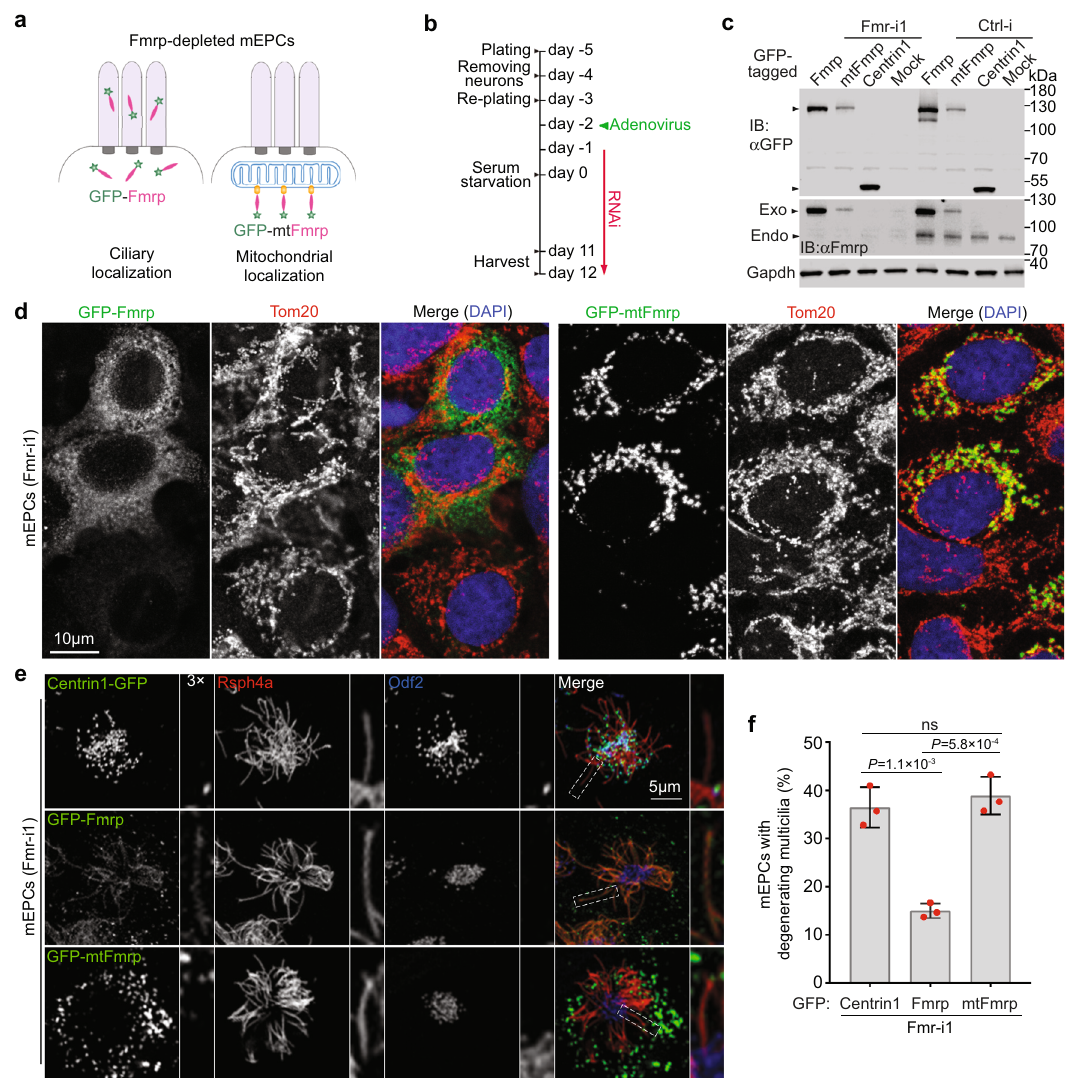
Fig. 6 Fmrp depletion-induced multicilia degeneration is attributed to the ciliary fraction of Fmrp. Pooled data were from three independent experiments and are presented as nean ± s.d. Two-tailed student ’ s t -test: ns no signi fi cance. a Diagrams illustrating rescue experiments using adenovirus-expressed GFP-Fmrp and a mitochondrial tethered form, GFP-mtFmrp. b Experimental scheme of the rescue experiments. mEPCs were harvested at day 12 unless described otherwise. c Expression levels of GFP-tagged proteins. Gapdh served as loading control. Exo exogenous Fmrp, Endo endogenous Fmrp. d GFP- mtFmrp displayed mitochondrial localization in cell bodies of day-10 mEPCs. Tom20 served as mitochondrial marker. e GFP-Fmrp, but not GFP-mtFmrp, displayed multicilia localization in mEPCs transfected with Fmr-i1. Centrin1-GFP was used as negative control. Rsph4a and Odf2 served as ciliary and basal body markers, respectively. Typical cilia (framed) were magni fi ed to show details. f Incidence of multicilia degeneration. 689 (Centrin-GFP), 762 (GFP- Fmrp), and 343 (GFP-mtFmrp) multiciliated cells from three biologically independent experiments were